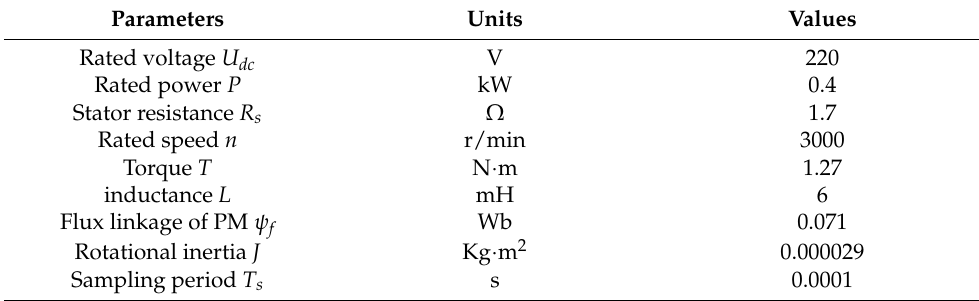
Table 1. Parameters of the PMSM